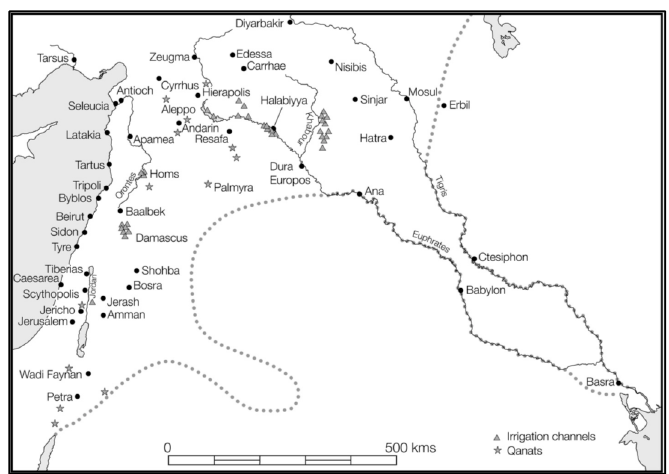
Figure 11. Map of the near east in the Roman period, showing the distribution of irrigation channels (triangles) and qanats (stars) (prepared by Alison Wilkins [92]).